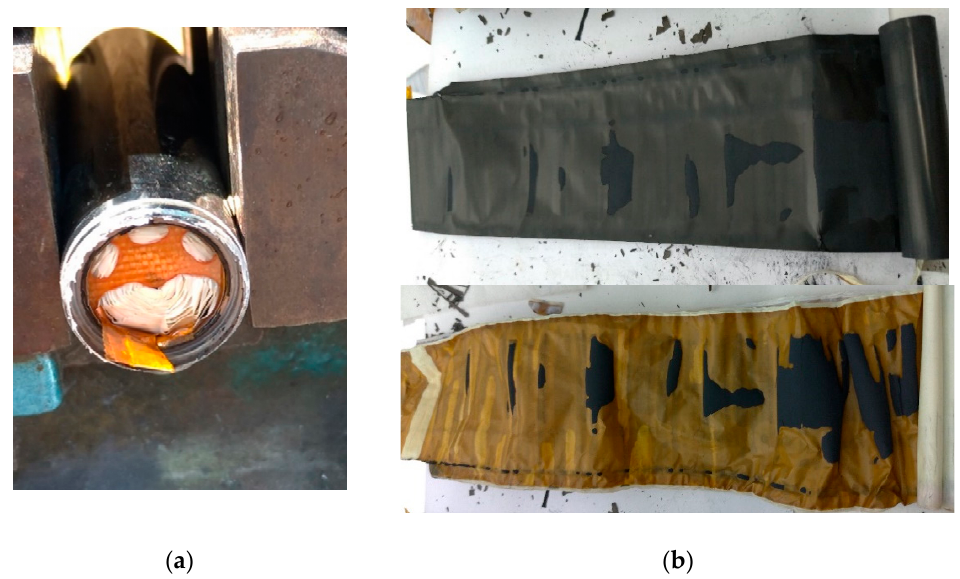
Figure 4. Disassembling of an abused cell: ( a ) protection systems removal, ( b ) electrodes and separator disassembling.